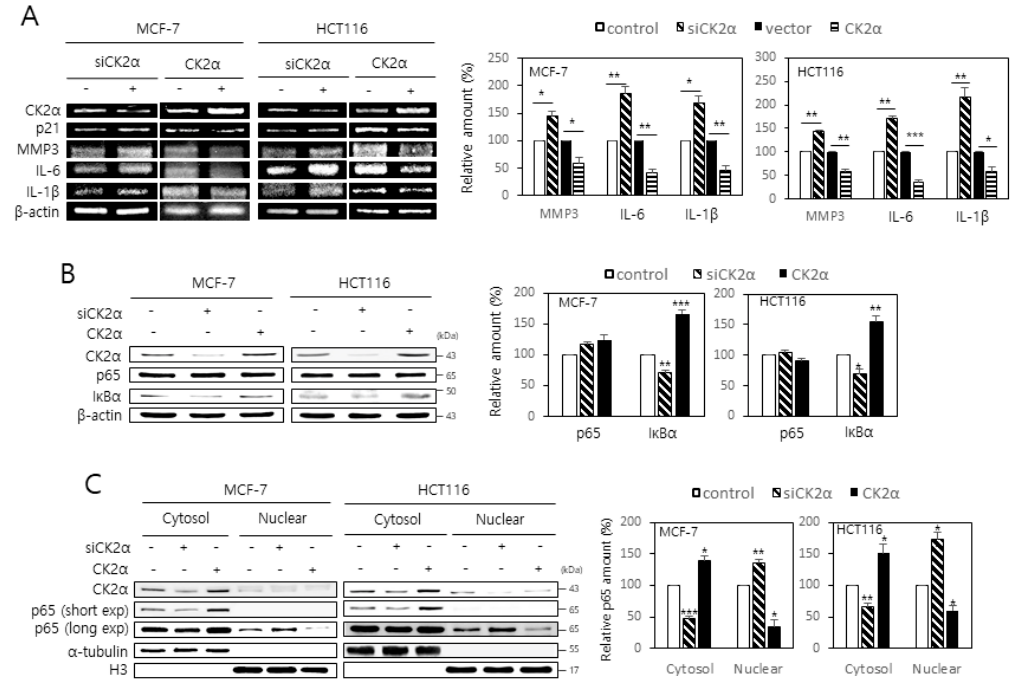
Figure 1. CK2 down-regulation stimulates the expression of senescence-associated secretory phenotype (SASP) factors by enhancing the nuclear localization of NF-kB in human cancer cells. MCF-7 and HCT116 cells were transfected with CK2 α siRNA or pcDNA3.1-HA-CK2 α for two days. ( A ) The level of each mRNA was measured by RT-PCR using gene-specific primers ( left ). Representative data from three independent experiments are shown. β -Actin was used as a control. Graphs represent the quantitation of each mRNA relative to β -actin ( right ). ( B ) The level of each protein was determined by immunoblot analysis using specific antibodies ( left ). Representative data from three independent experiments are shown. β -Actin was used as a control. Graphs represent the quantitation of each protein relative to β -actin ( right ). ( C ) Cytoplasm and nuclei were isolated from cells, and both extracts were visualized by immunoblotting. α -Tubulin (cytoplasmic marker) and histone H3 (nuclear marker) were quantified as loading controls ( left ). Representative data from three independent experiments are shown. Graphs represent the quantitation of RelA/p65 relative to the subcellular markers ( right ). exp, exposure. Data are mean ± standard error of the mean (SEM). * p < 0.05; ** p < 0.01; *** p < 0.001.